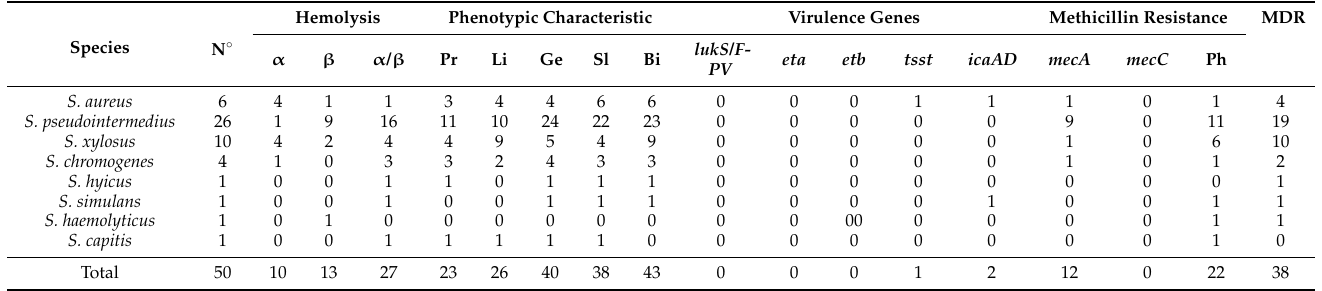
Table 2. Results of the phenotypic and genotypic tests performed on the examined Staphylococcus isolates.